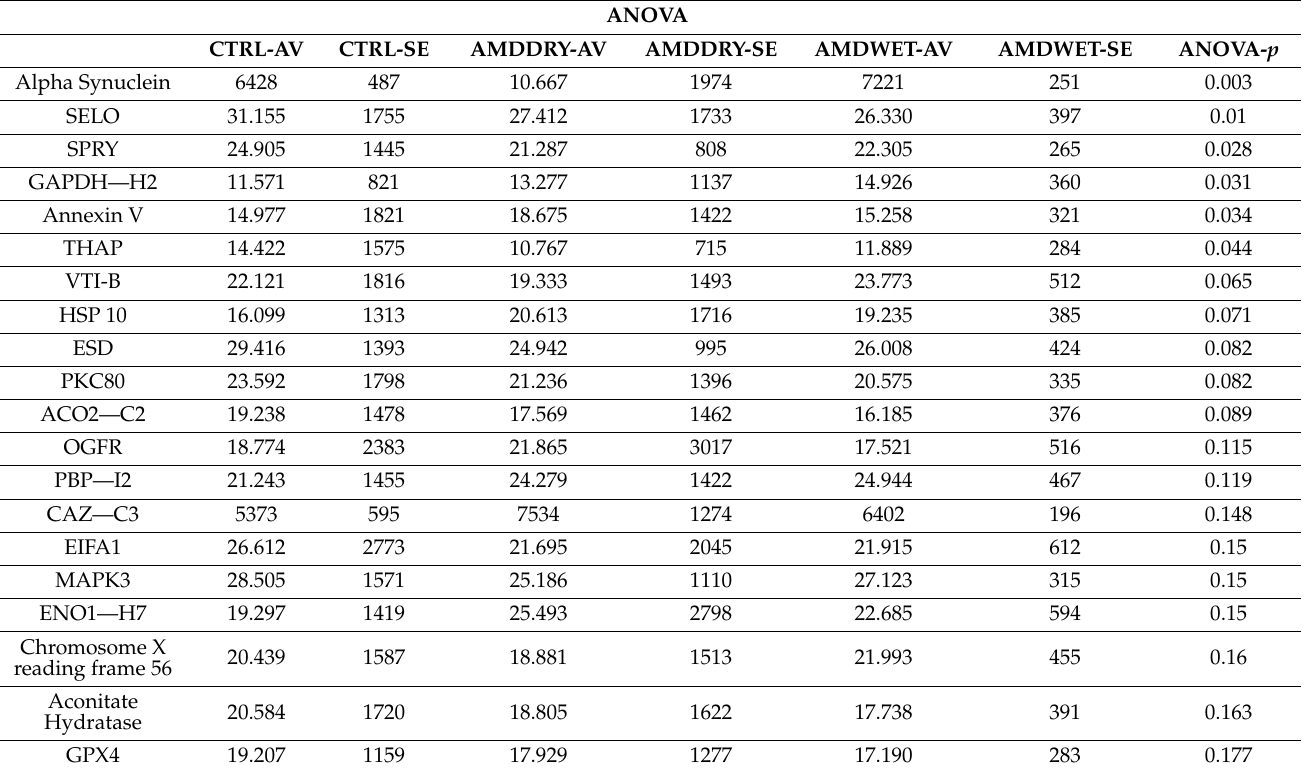
Table 3. ANOVA (Analysis of Variance) of the IgG immunoreactivities in wet AMD and dry AMD samples compared to